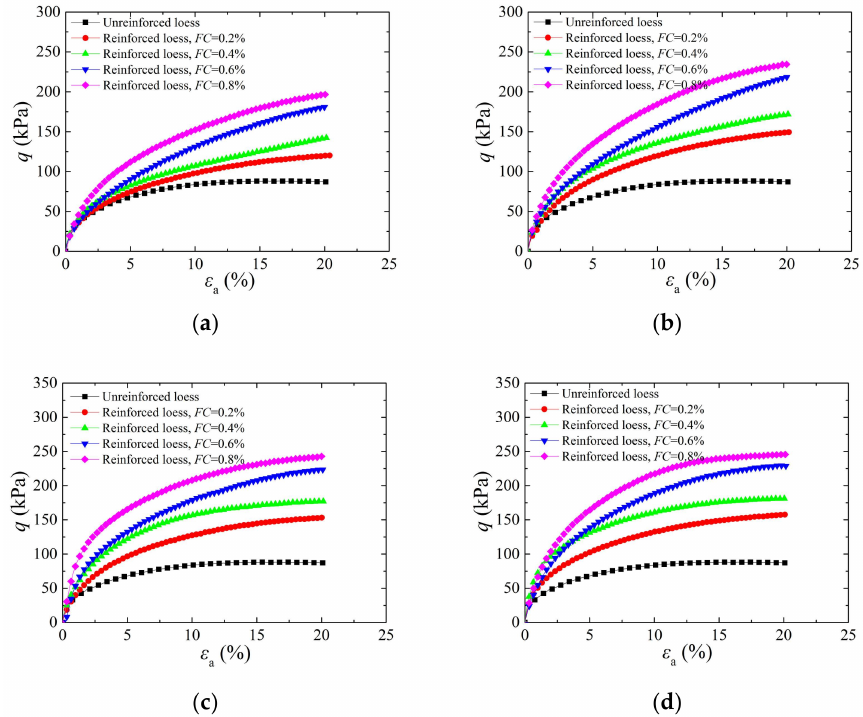
Figure 3. Effect of fiber content on stress–strain curves under 50 kPa cell pressure: ( a ) FL = 4 mm; ( b ) FL = 8 mm; ( c ) FL = 12 mm; ( d ) FL = 16